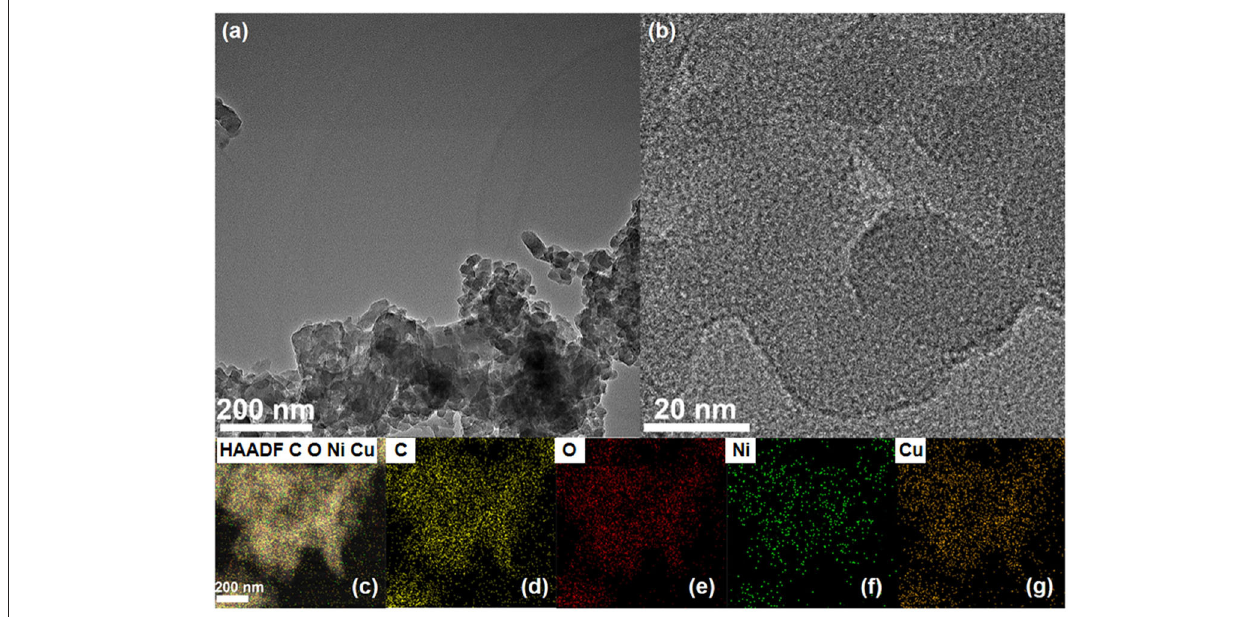
FIGURE 2 | (a,b) TEM images of the NiCu-CAT nanocrystal. (c–g) The distribution images of various elements of NiCu-CAT